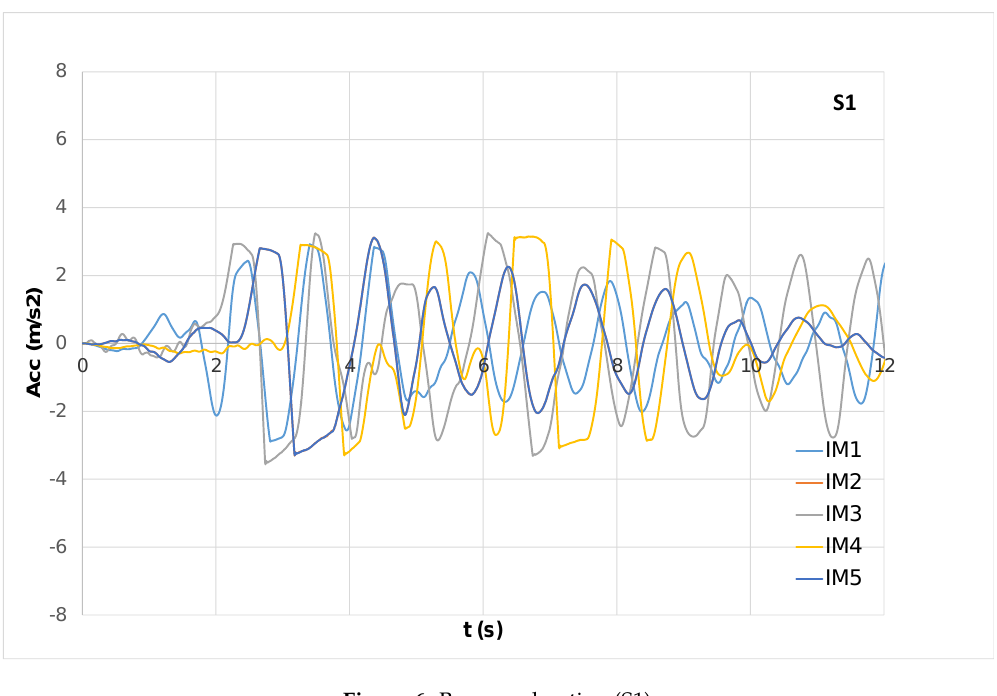
Figure 6. Base acceleration (S1).